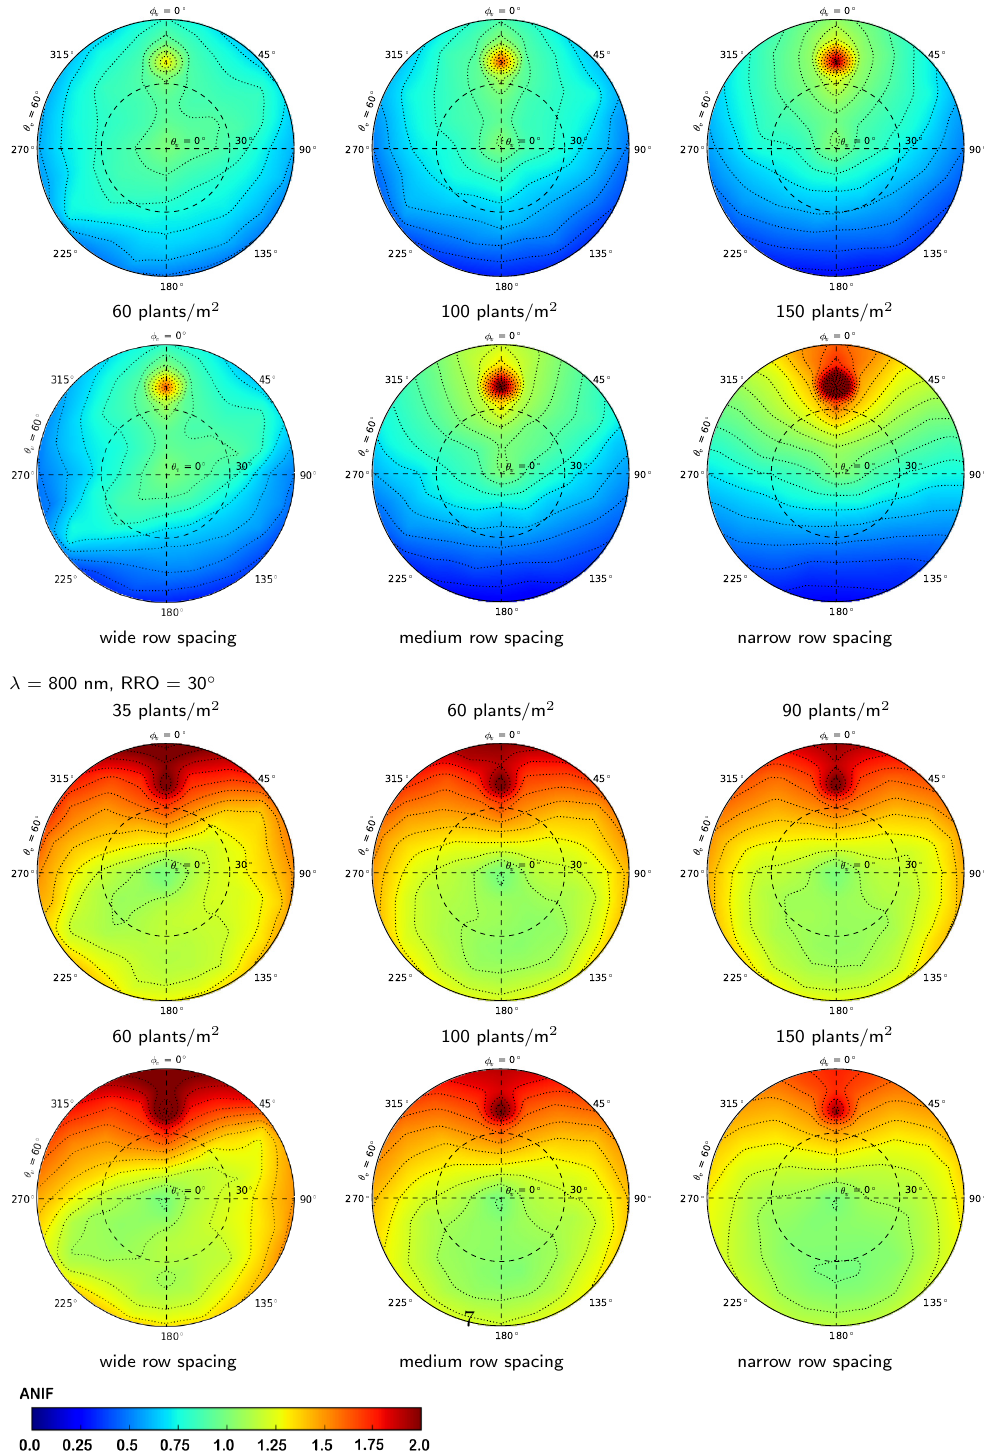
Figure 8. BRDF of winter wheat canopies during early stem elongation at λ = 670 nm and λ = 800 nm for wide, medium and narrow spacing between plant rows and for different plant